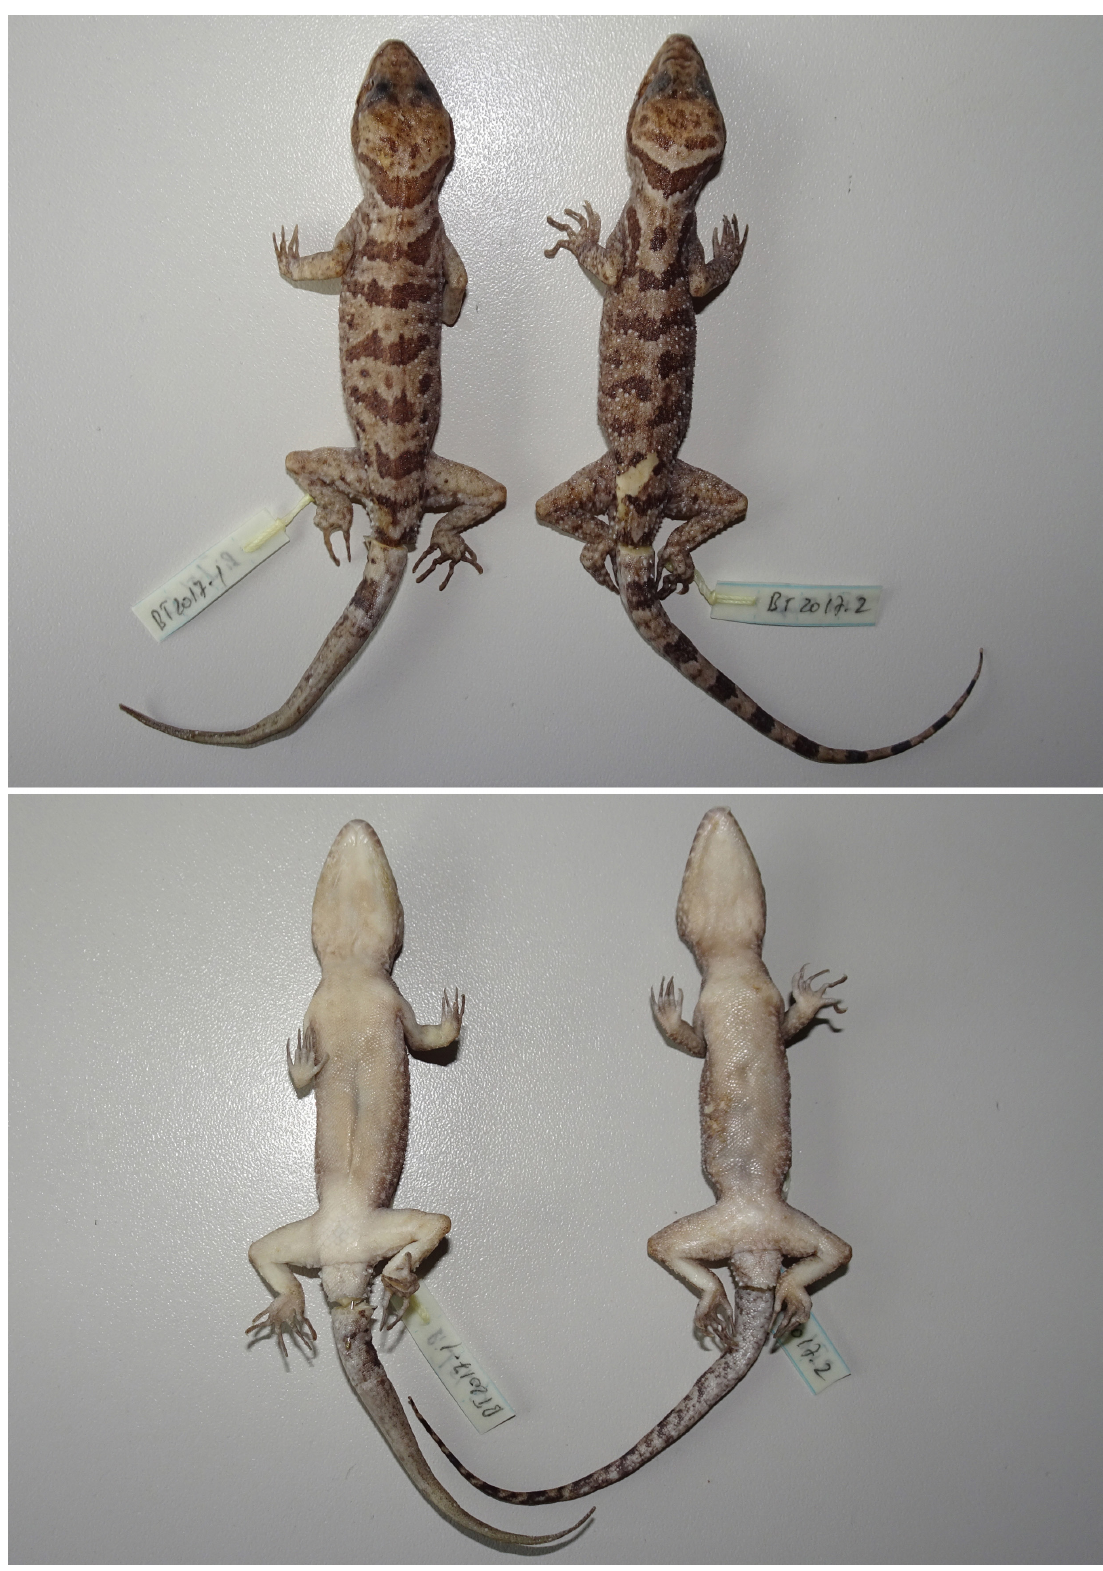
Fig. 5. Cyrtodactylus chungi sp. nov., holotype, ♂ (IEBR 4581) and paratype, ♀ (IEBR 4582). Views in preservative. Top: dorsal view. Bottom: ventral view. Photos T.